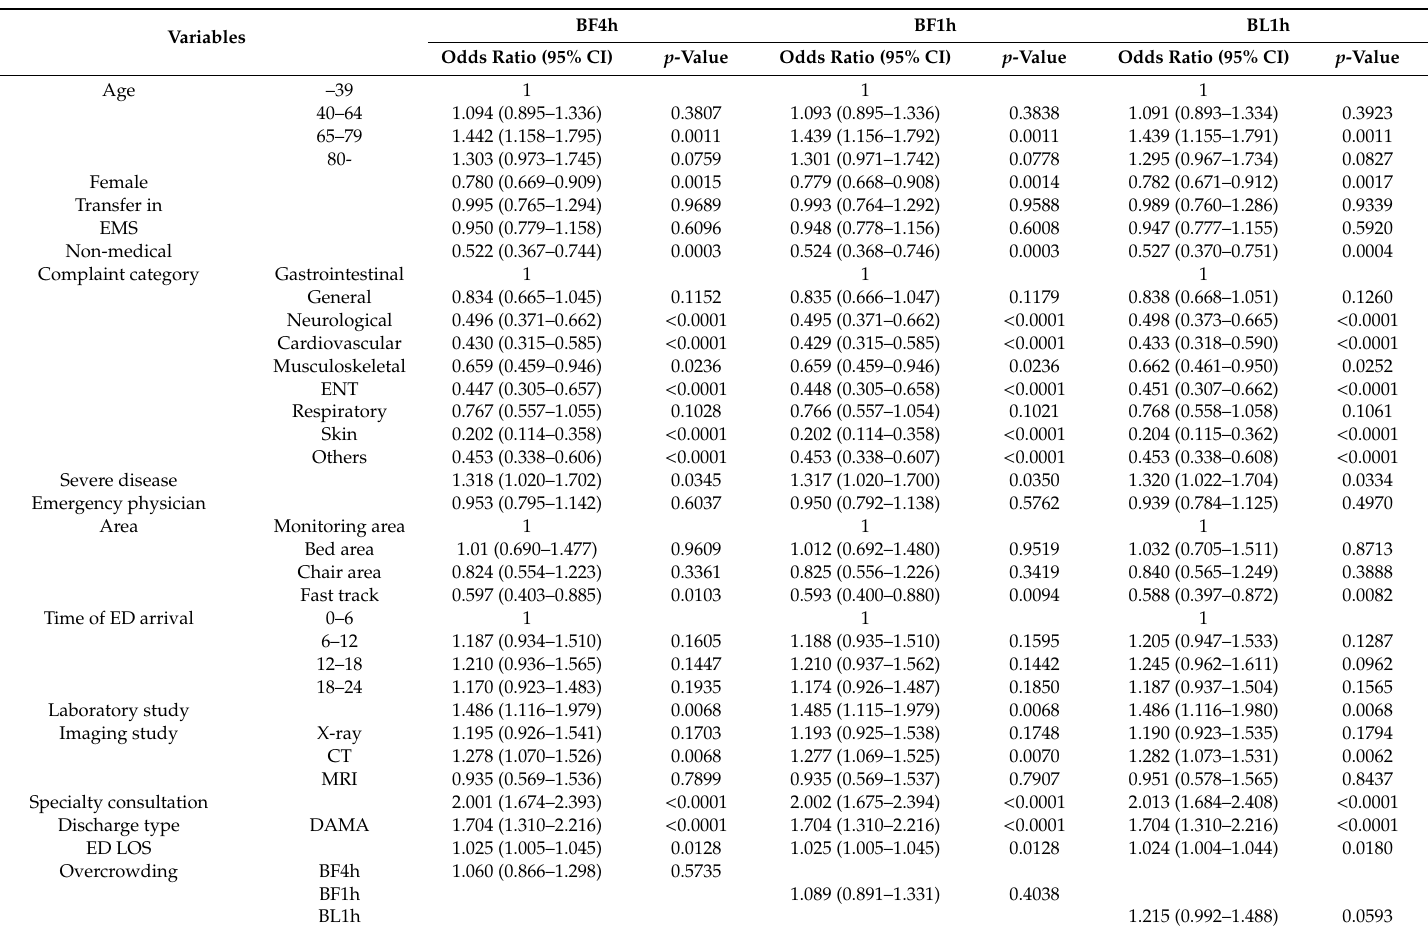
Table A8. Multivariable logistic regression of emergency department overcrowding of the number of boarding patients for return visit with admission.